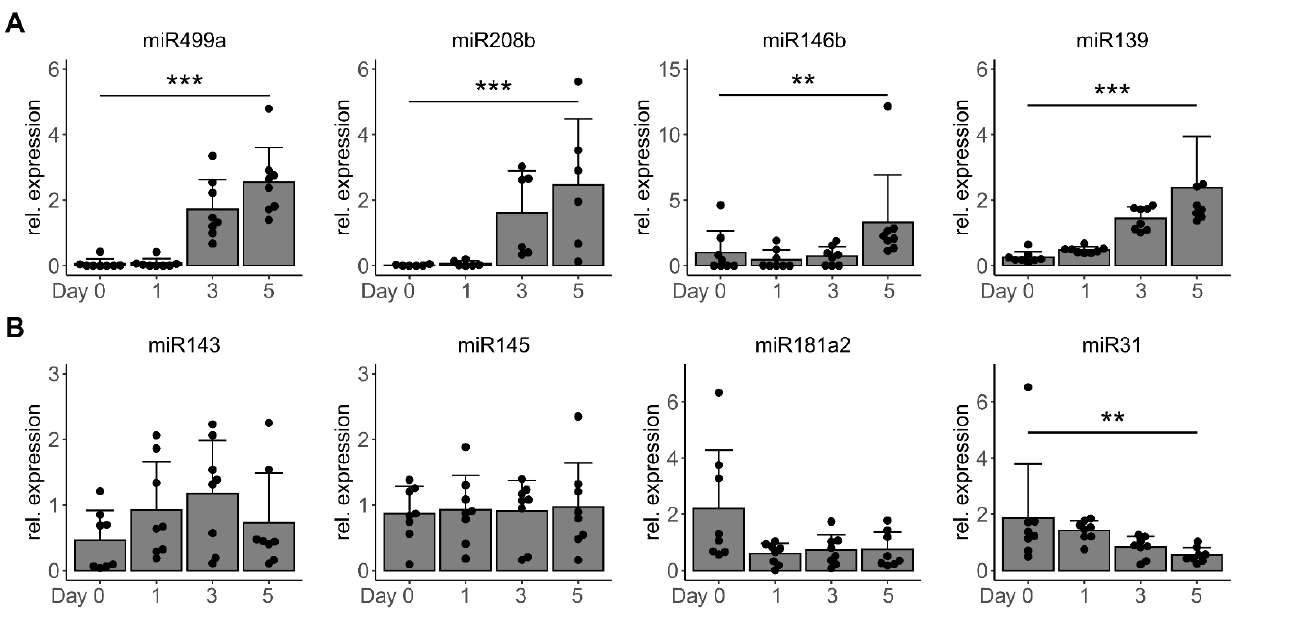
Figure 2. Expression of TGF- β -regulated miRNAs during skeletal muscle cell differentiation. Primary human myoblasts ( n = 8) were differentiated towards myotubes for 5 days without FBS. Day 0 equals the start of differentiation by serum withdrawal. Expression of mature miRNAs was analyzed by qPCR on day 1, 3, and 5 of the differentiation process. ( A ) miRNAs identified as downregulated by TGF- β1 treatment of myoblasts. ( B ) miRNAs identified as upregulated by TGF- β1 treatment of myoblasts. All qPCR data were normalized to individual donors and reference RNU6. Individual datapoints are displayed, bars represent mean ±SD. All data were analyzed using the Kruskal test for trend. ** p < 0.01, *** p < 0.001.